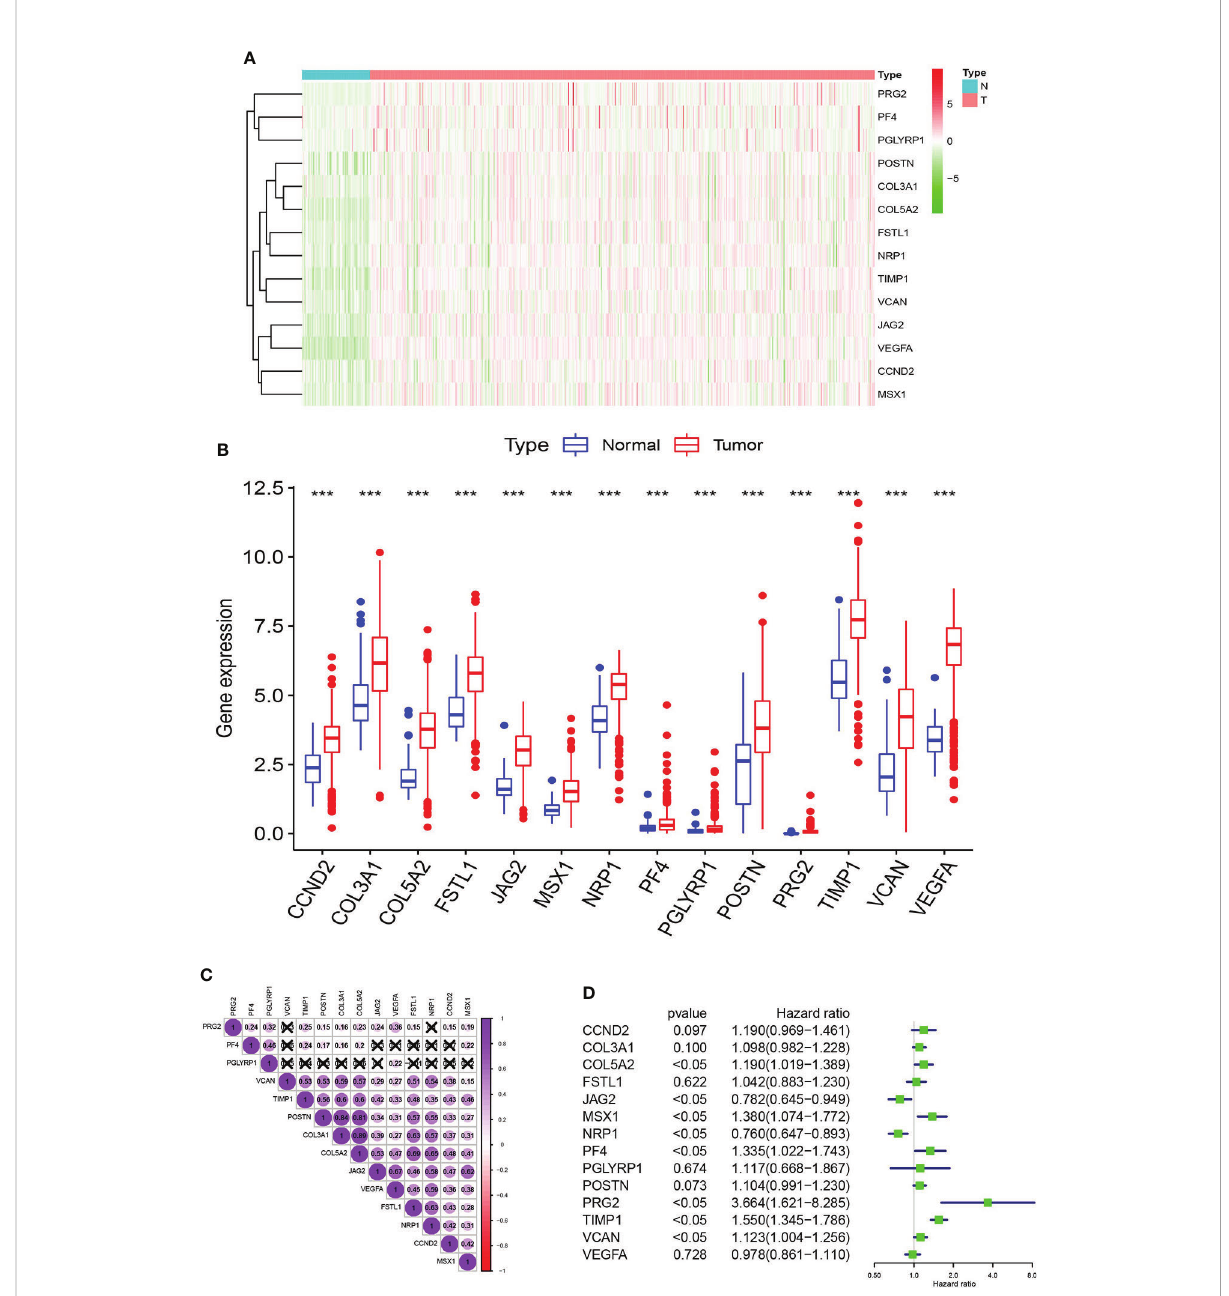
FIGURE 1 AAGs screening. Heat map (A) and box plot (B) showing the expression distributions of differentially expressed genes between KIRC and normal samples of the AAGs. (C) Correlation analysis of the 14 AAGs. (D) Univariate Cox regression analysis of 14 AAGs. The meaning of the symbol *** is